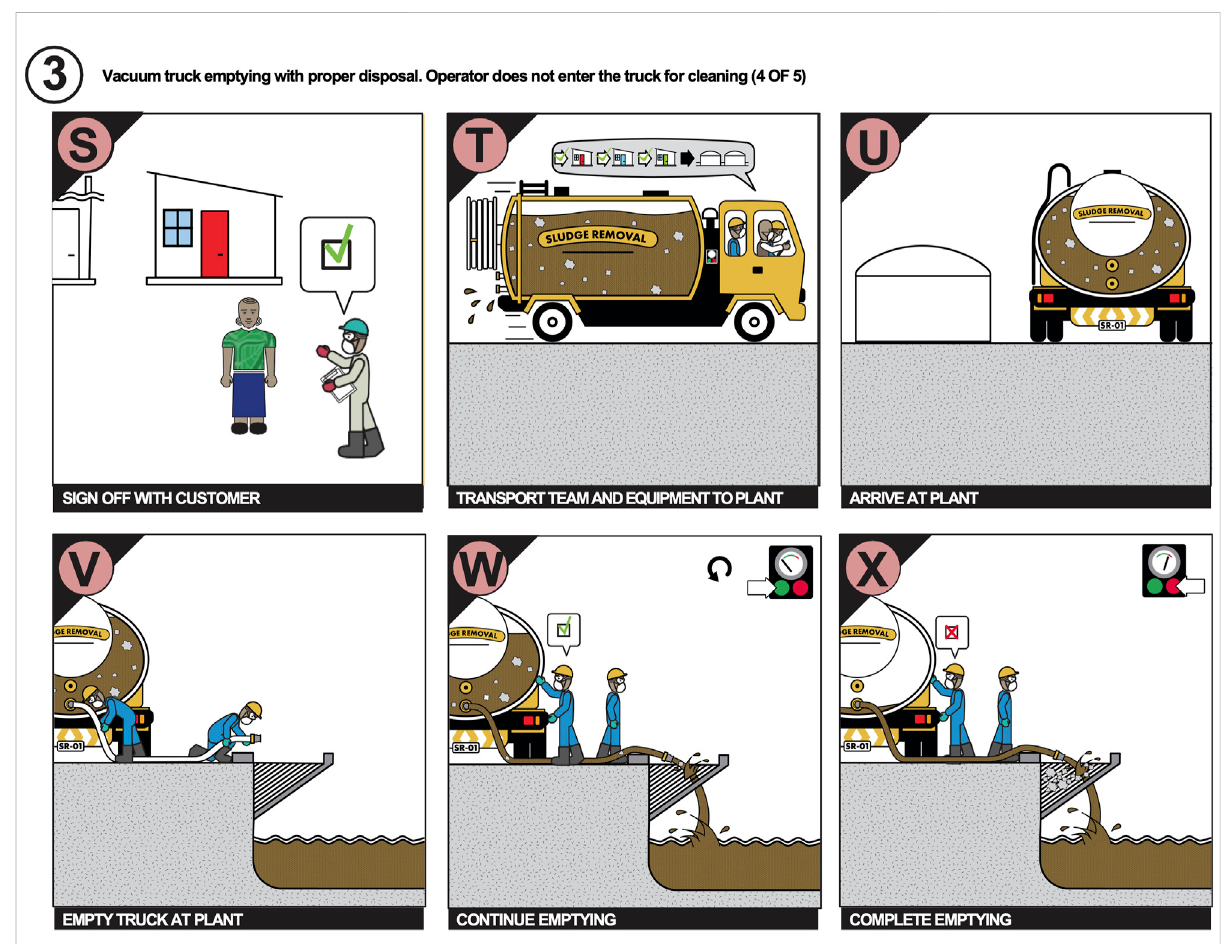
FIGURE 3 Excerpt of vacuum truck emptying with proper disposal. Operator does not enter the truck for cleaning. See Supplementary Material for the complete set. The panel labels correspond to the chronological labels used in the complete